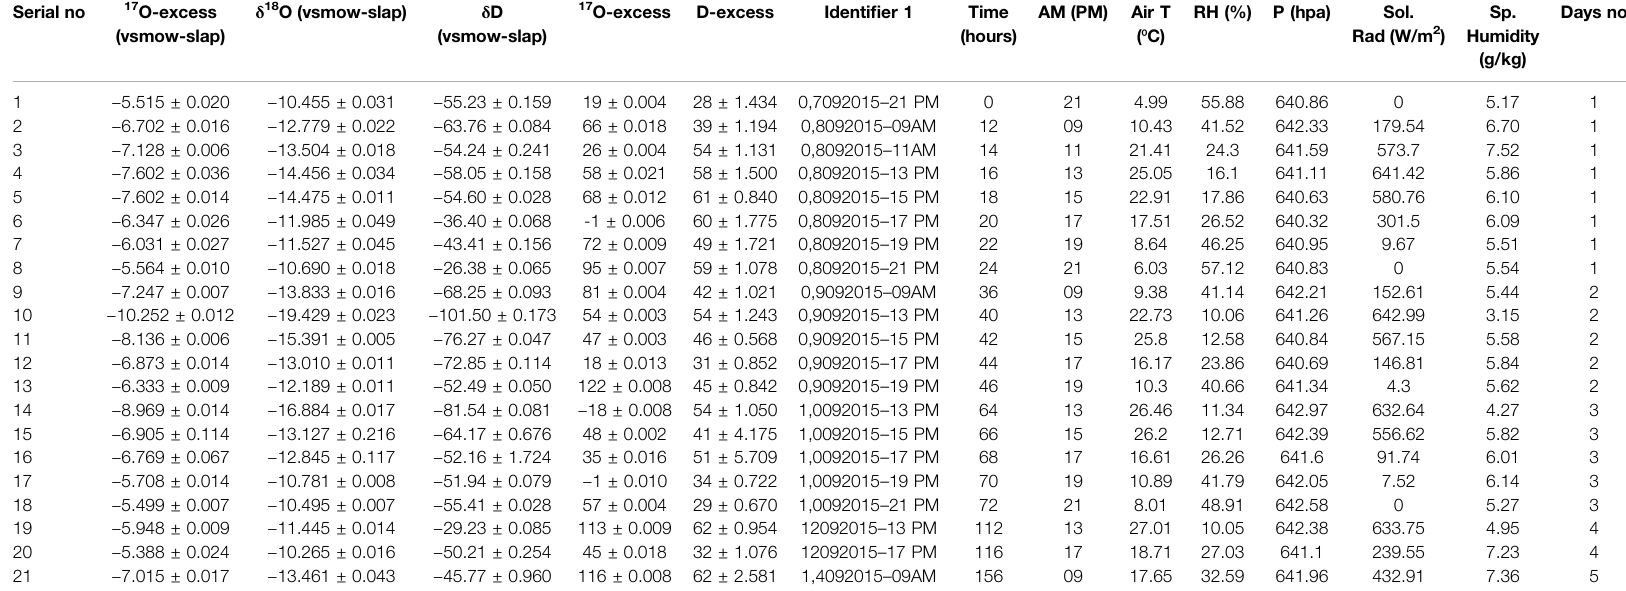
TABLE1| Tripleoxygenisotopes(withuncertainty)andmeteorologicalparametersofvaporsamplesofChhotaShigriglacier,westernHimalaya.ErrorestimateforD-excesswascalculatedbasedontheuncertainlybetween δ D and δ 18 O (Froehlich et al., 2002). Serial